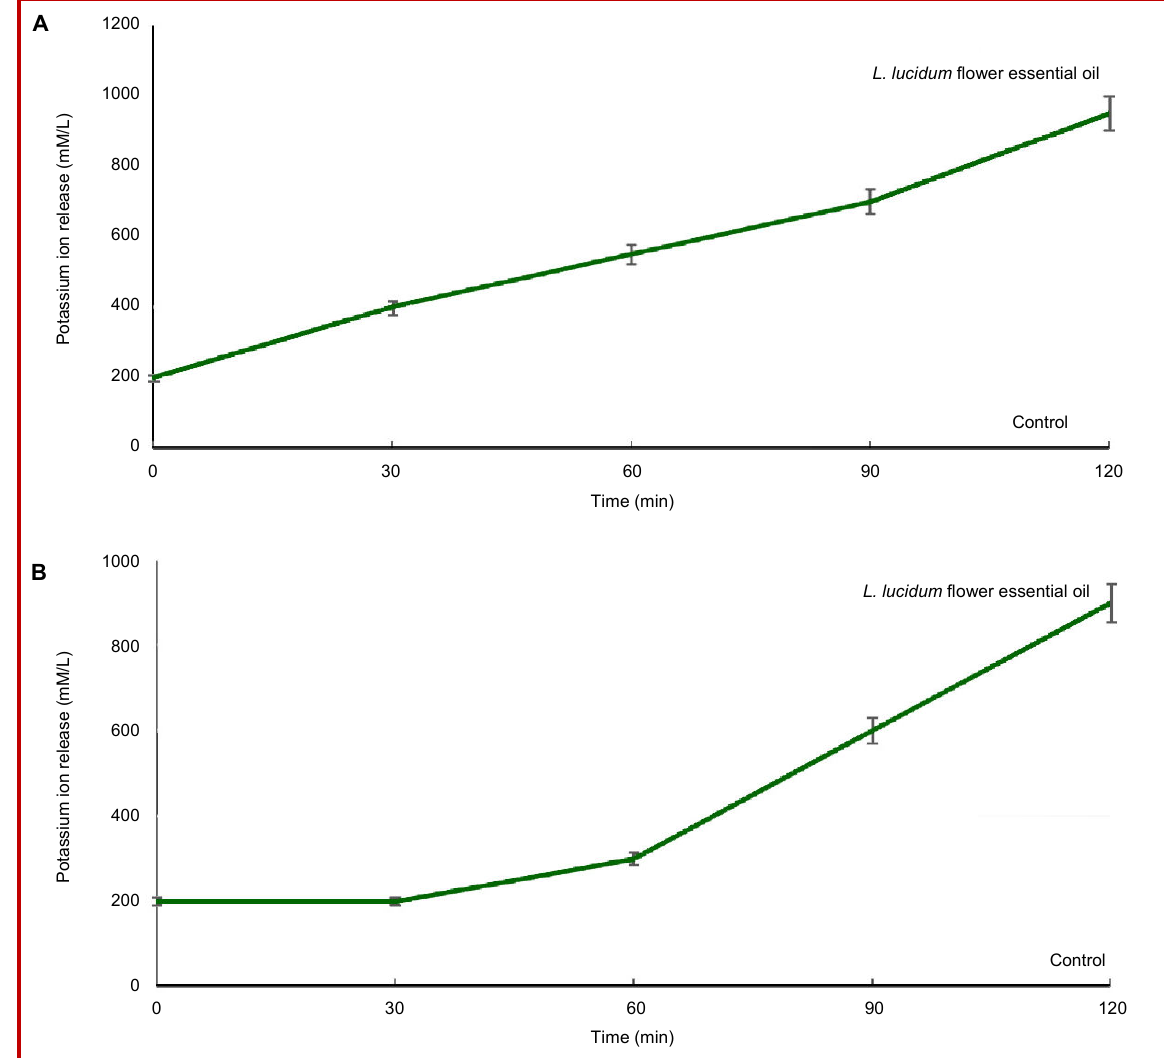
Figure 3: Effect of flower essential oil of Ligustrum lucidum on leakage of potassium ions from the tested pathogenic bacteria of S. aureus KCTC-1621 (A) and S. enterica ATCC-4731 (B). CT: control without